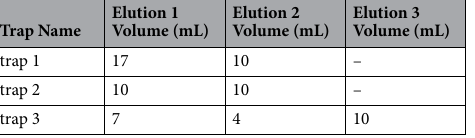
Table 1. Volumes of water used to elute 76/77 Br isotopes from traps 1, 2, and 3.